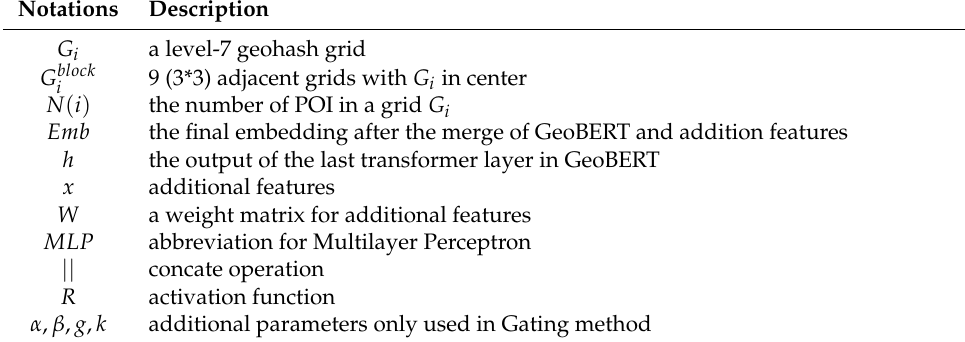
Table 8. Summary of primary